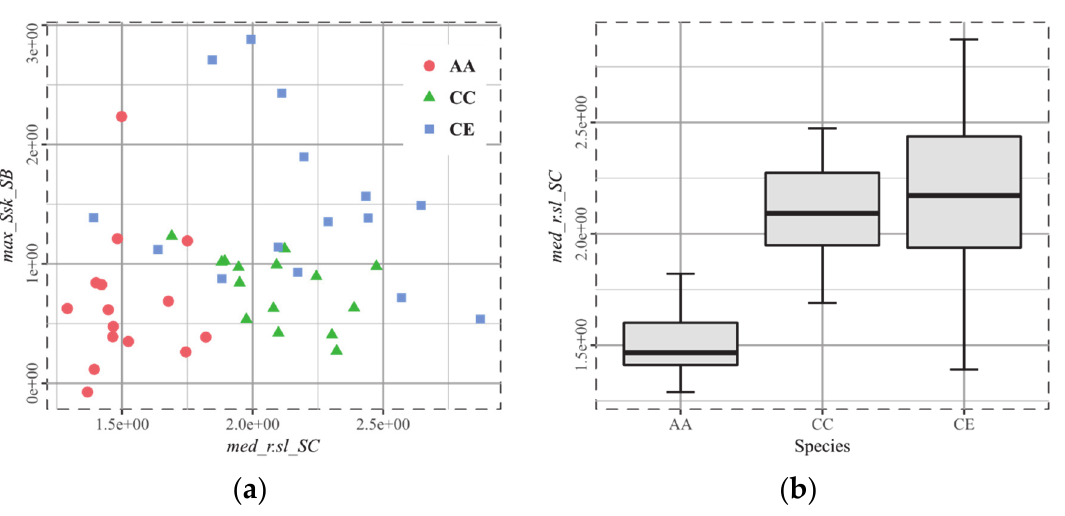
Figure 10 . Cervid, most discriminating parameters. ( a ) The anisotropy parameter r.sl isolates the browsing moose (AA), the skewness reaches higher values for the red deer (CE); and, ( b ) med_r.sl_SC is statistically lower for AA, even if CE spans a wide range of values.